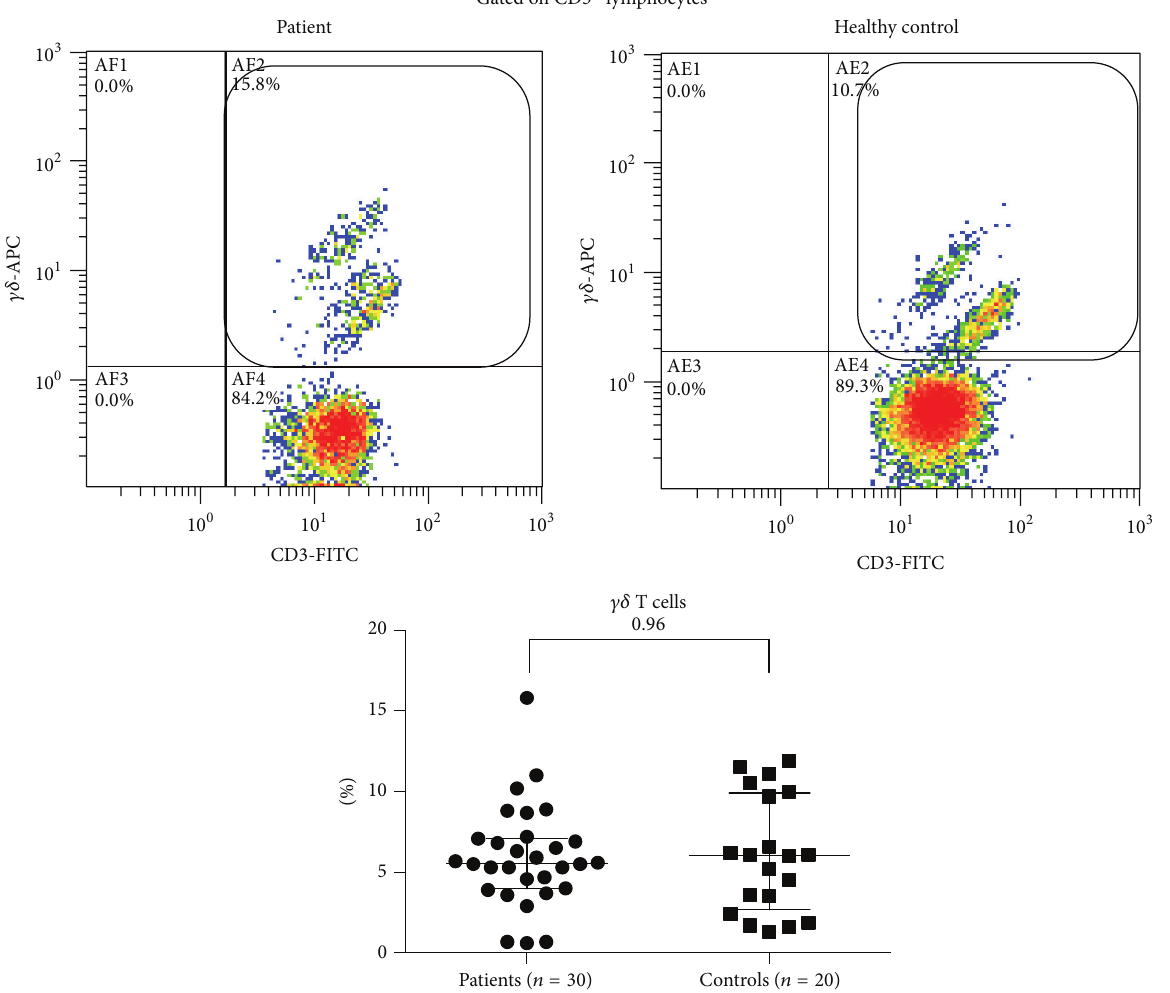
Figure 2: In peripheral blood of 30 patients and 20 controls, 𝛾𝛿 T cells were identified by 𝛾𝛿 TCR+ cells on CD3 gate. Bars represent median with interquartile range. 𝑝 value (Mann-Whitney test) is mentioned in each